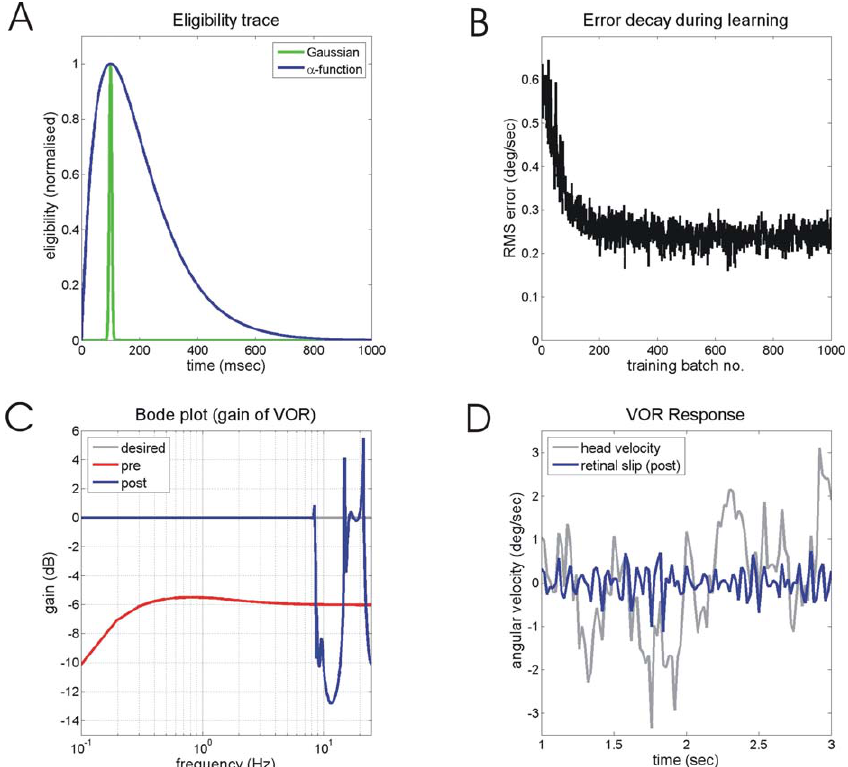
Figure 6. Effects of Eligibility Trace on VOR Calibration (A) Eligibility trace (blue line) used by Kettner et al. [40] and (B–D) compared to the trace required for VOR learning up to 25 Hz (green line). (B) Learning as measured by retinal slip error. (C) System gain for sinusoidal input signals as a function of frequency before and after learning. (D) Time course of retinal slip in response to colored-noise head-velocity input after learning.